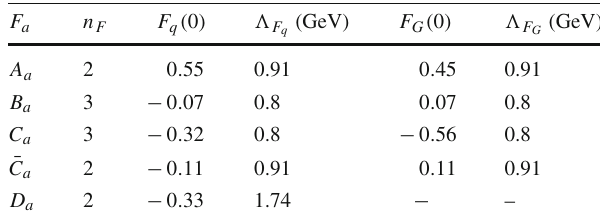
Table1 Parametersforthemultipoleparametrization (11)oftheGFFs, in the MS scheme with renormalization scale μ = 2